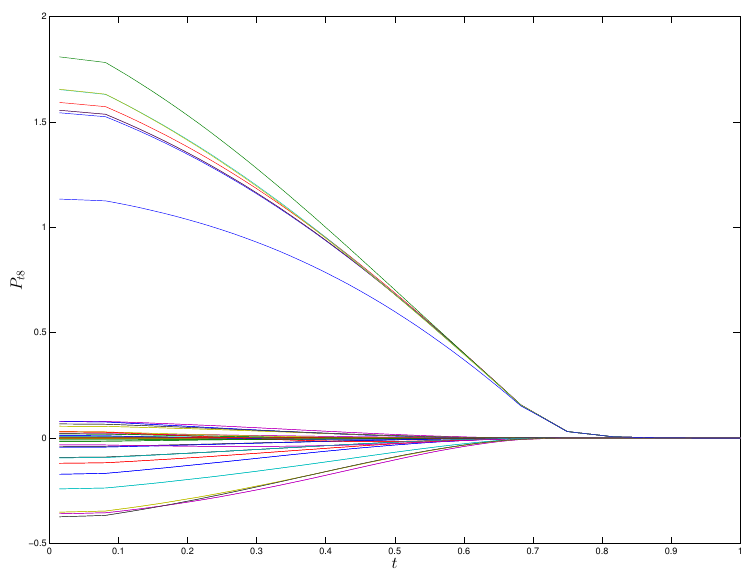
Figure 1. Elements in ¯ P t 8 with respect to t